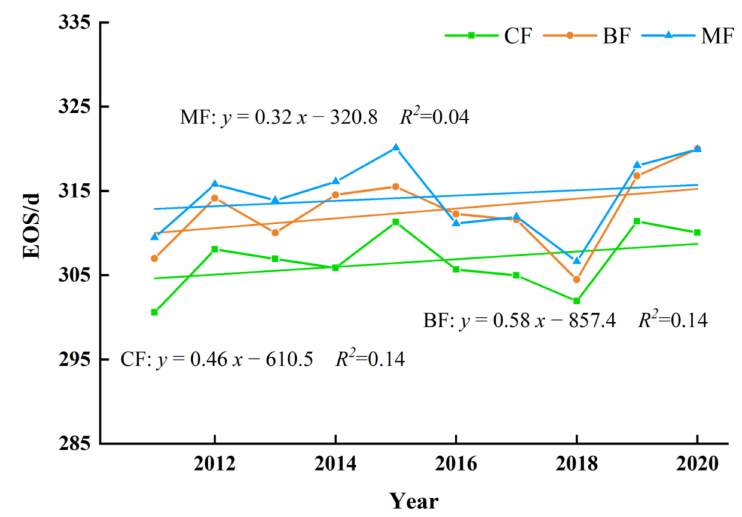
Figure 15. The annual changes of EOS in different forest types from 2011 to 2020.